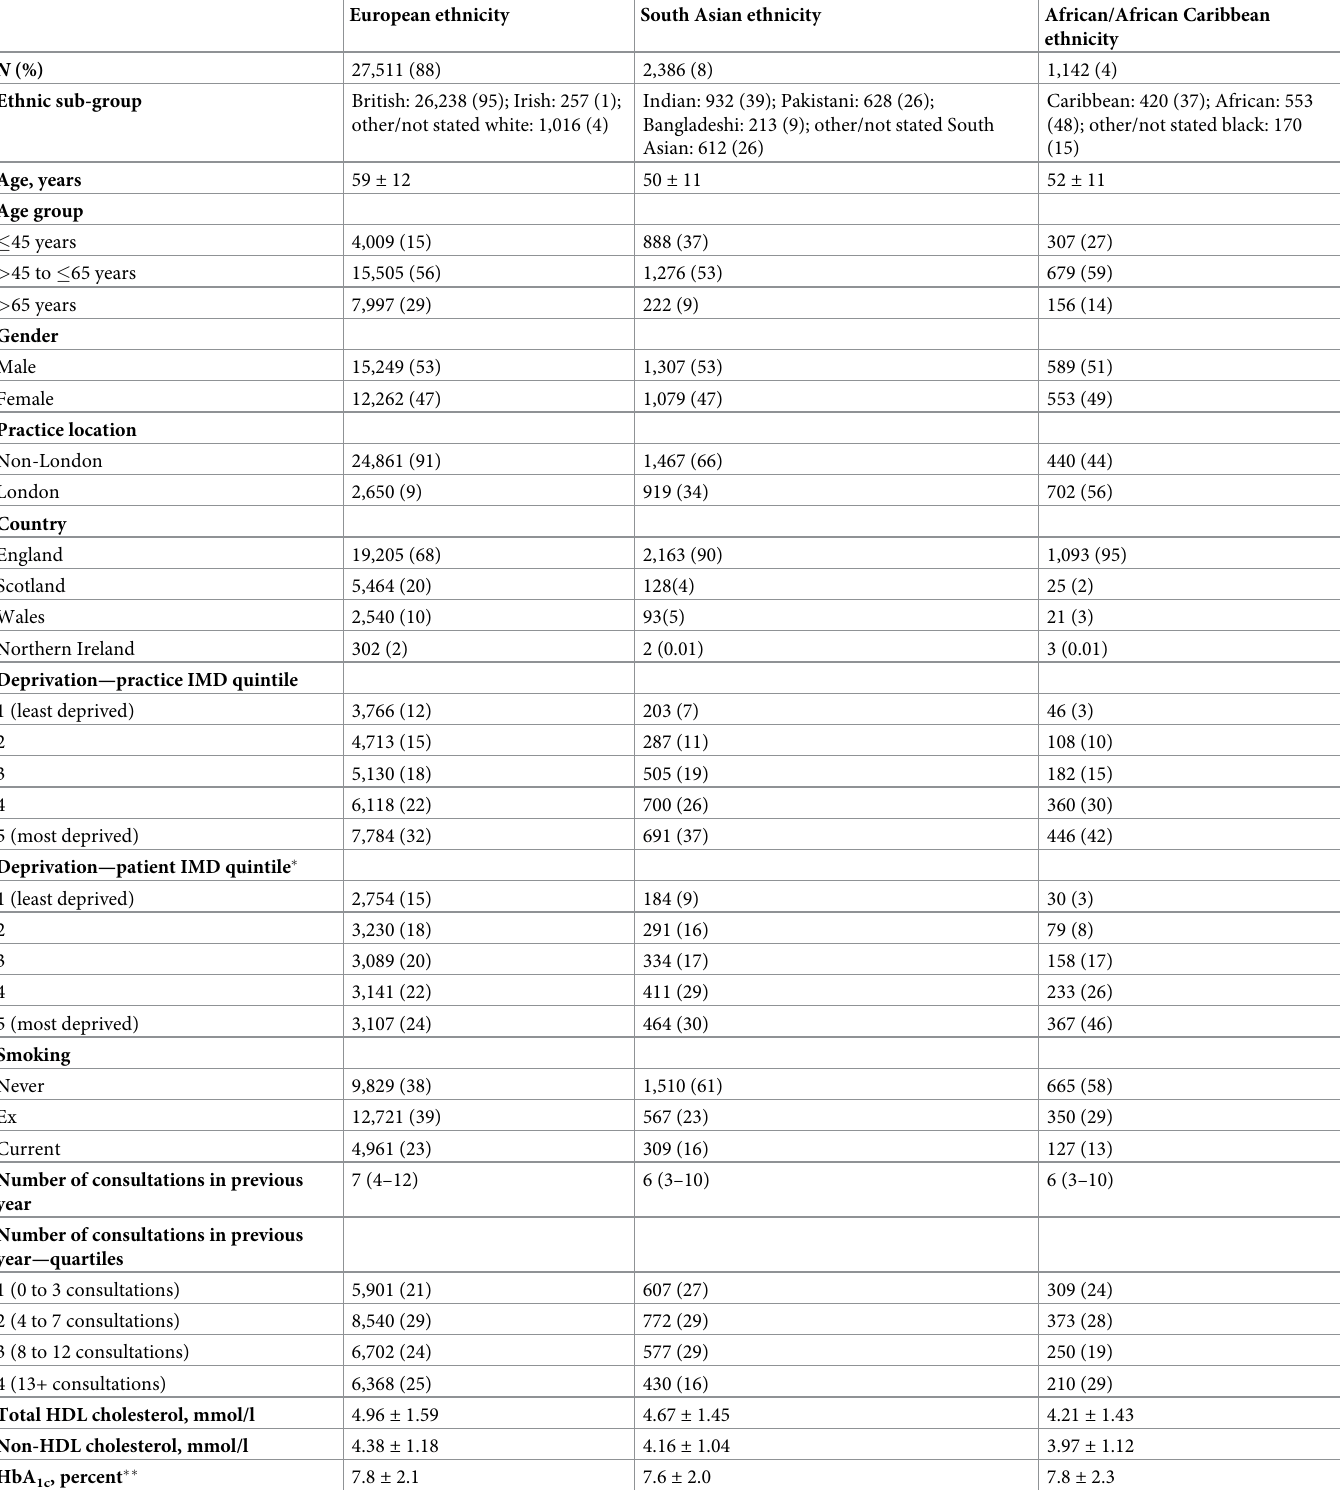
Table 2. Baseline characteristics of people with incident type 2 diabetes in 2006 or later AU : InthetitletoFig 2 ; Ichangedafter 2006 toin 2006 orlaterforconsistencywithdatesgivenelsewhereinthepaper : with no prior statin use or ASCVD, by ethnicity (complete case